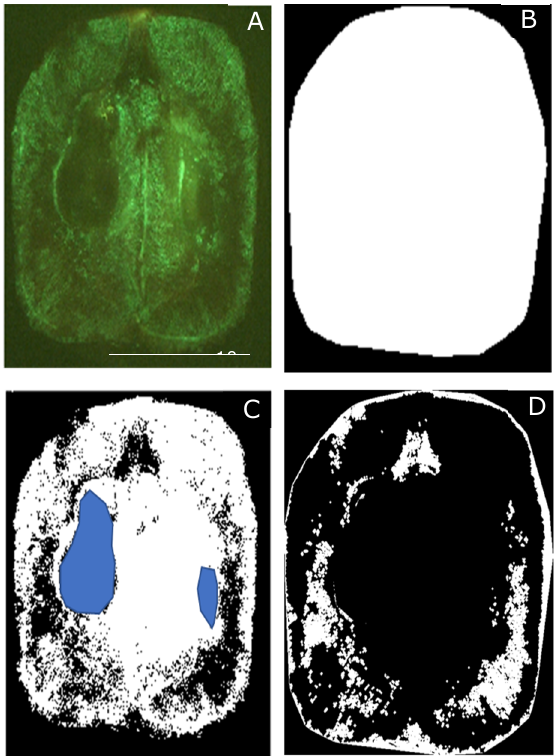
Figure 3. Example of fluorescent image ( A ) and analysis using computer vision algorithms for a Shiraz berry to obtain the berry contour and dimensions through edge recognition ( B ), living tissue, and seed extraction ( C ), and cell death quantification and patterns ( D ).